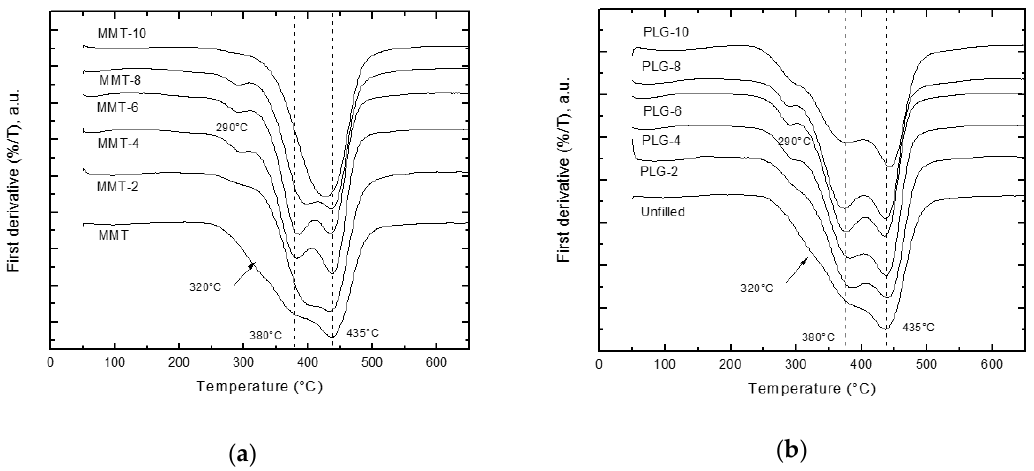
Figure 2. DTGA curves for nanocomposites prepared with either ( a ) MMT or ( b ) Figure 2 . DTGA curves for nanocomposites prepared with either ( a ) MMT or ( b ) PLG.